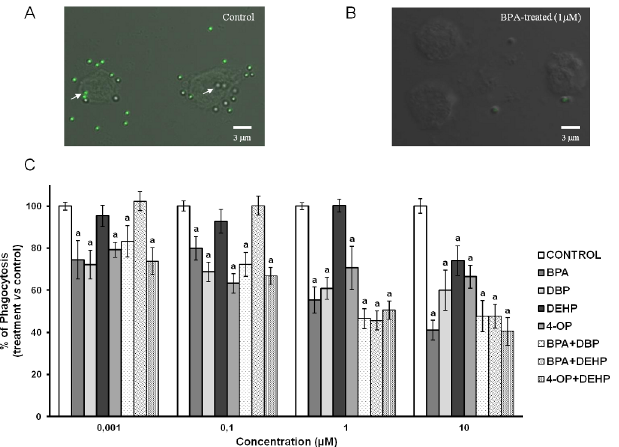
Fig 1. Effect of EDCs alone and in combination on phagocytosis by differentiated THP-1 cells. Differentiated THP-1 cells (PMA 5 ng/ml for 48 hours) were exposed to different concentrations (0.001, 0.1, 1 and 10 μ M) of BPA, DEHP, DBP, 4-OP or a combination of both for 24 hours. Culture medium was replaced by fresh medium containing 10 ng/ml of LPS for a subsequent 24 hours of incubation. Panels A and B depict confocal laser microscopy analysis of phagocytosis of FITC-latex beads by untreated differentiated THP-1 cells (A) or by differentiated THP-1 cells exposed to BPA (B). Arrows show examples of phagocytized FITC- beads. Panel C represents the effects of BPA, DEHP, DBP, 4-OP and a combination of both (BPA + DEHP, BPA + DBP, 4-OP + DEHP) on phagocytosis of latex beads by differentiated THP-1 cells. Values are means ± SD (N = 3). Each experiment has been performed three times and in triplicate. a: vs control (One- way ANOVA, Tukey post test, p <